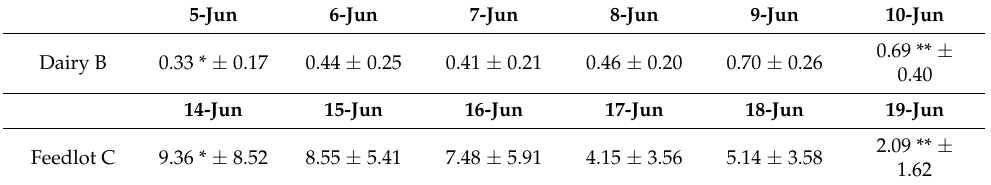
Table 2. Mean PM 2.5 EF (kg 1000-hd − 1 d − 1 ) in station1 FRM sampler of Dairy B and Feedlot C.